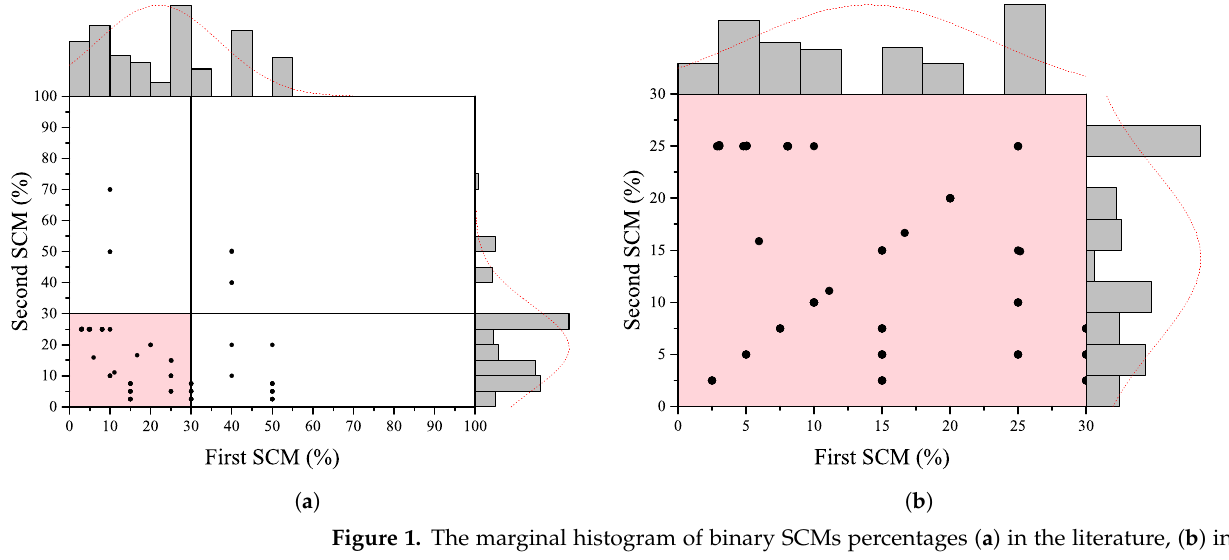
Figure 1. The marginal histogram of binary SCMs percentages ( a ) in the literature, ( b ) in the cur- rent